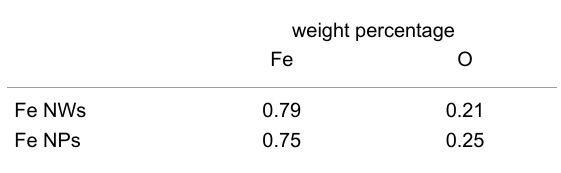
Table 1: Weight percentage of iron and oxygen contents in iron nanowires and iron nanoparticles derived from EDX measurements.